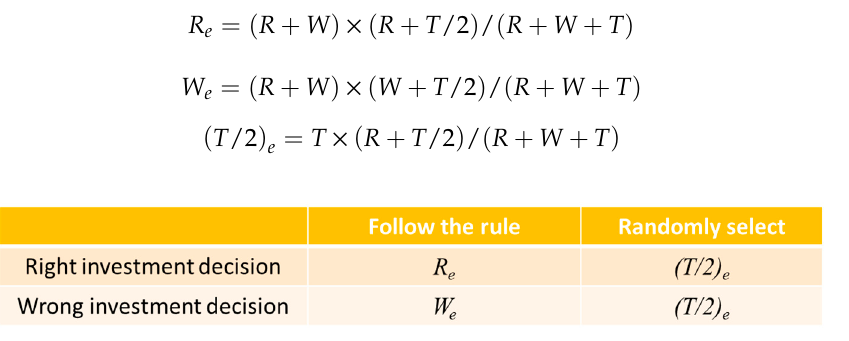
Figure 3. Observed frequencies: f o.